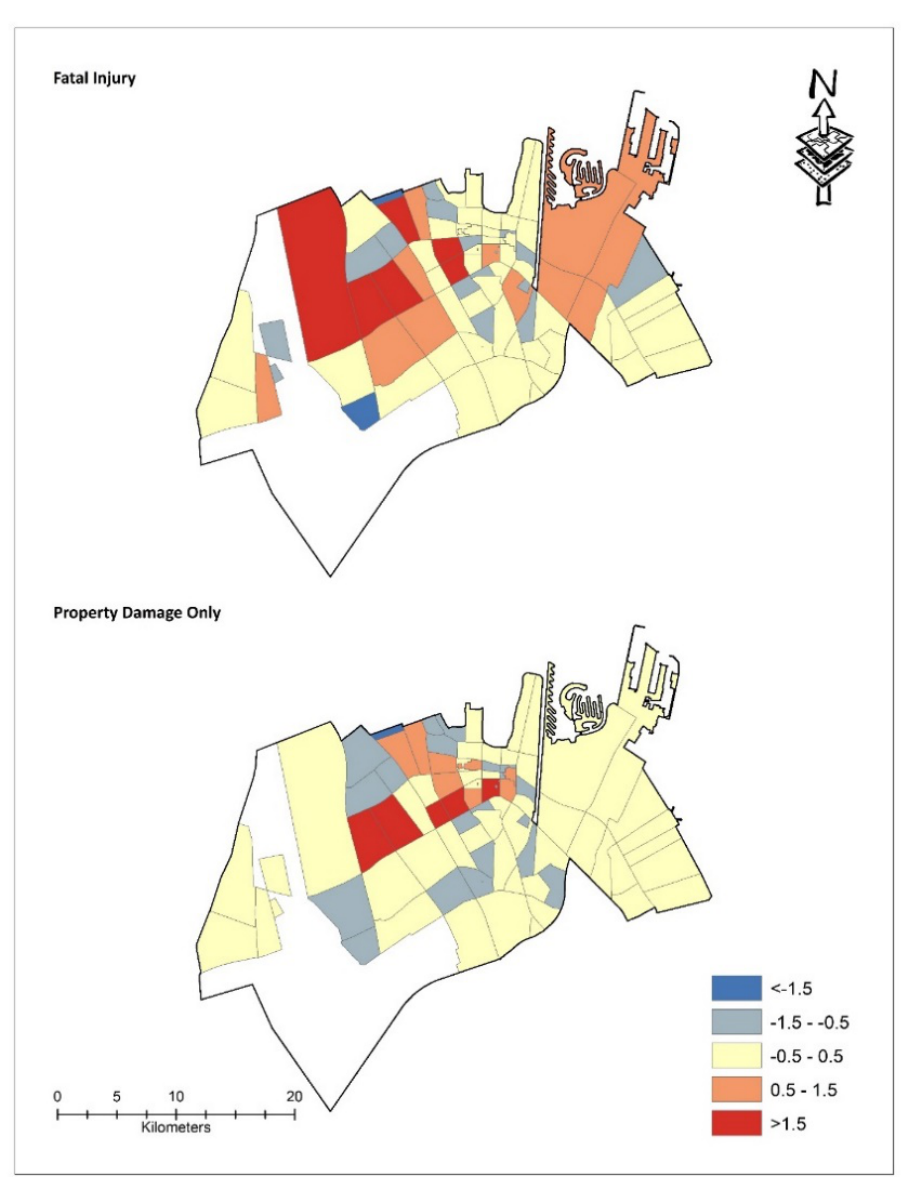
Figure 7. Distribution of the standard deviations of the residuals (SDR) values for crash severity